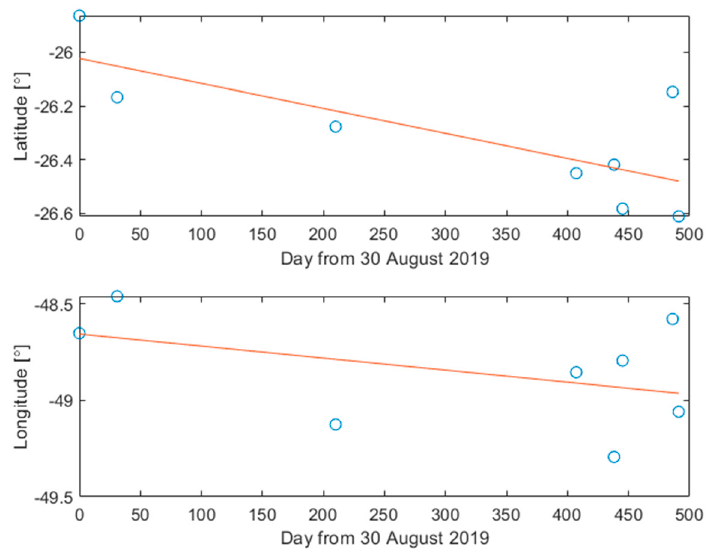
Figure 9. Development of the SAA centroid.